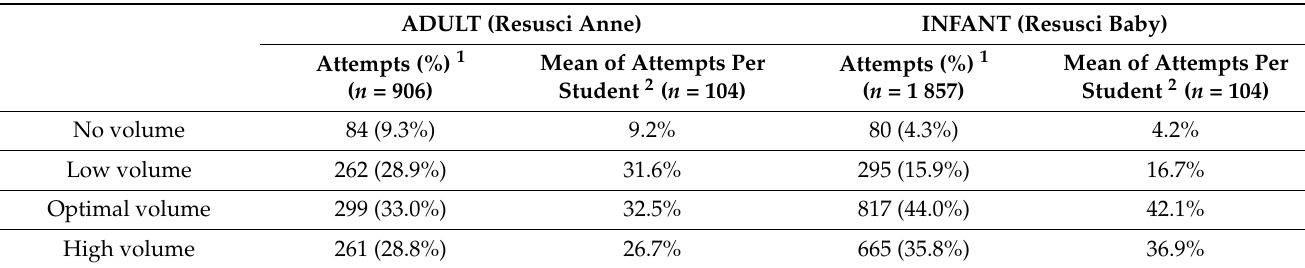
Table 2. Breath volume for Resusci Anne versus Resusci